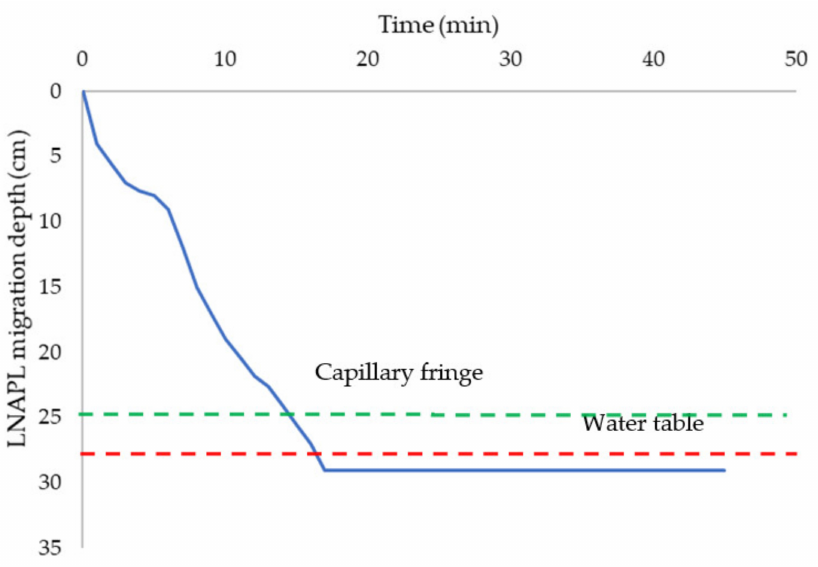
Figure 4. The behavior of 15 × 0 mL diesel volume in capillary fringe and water